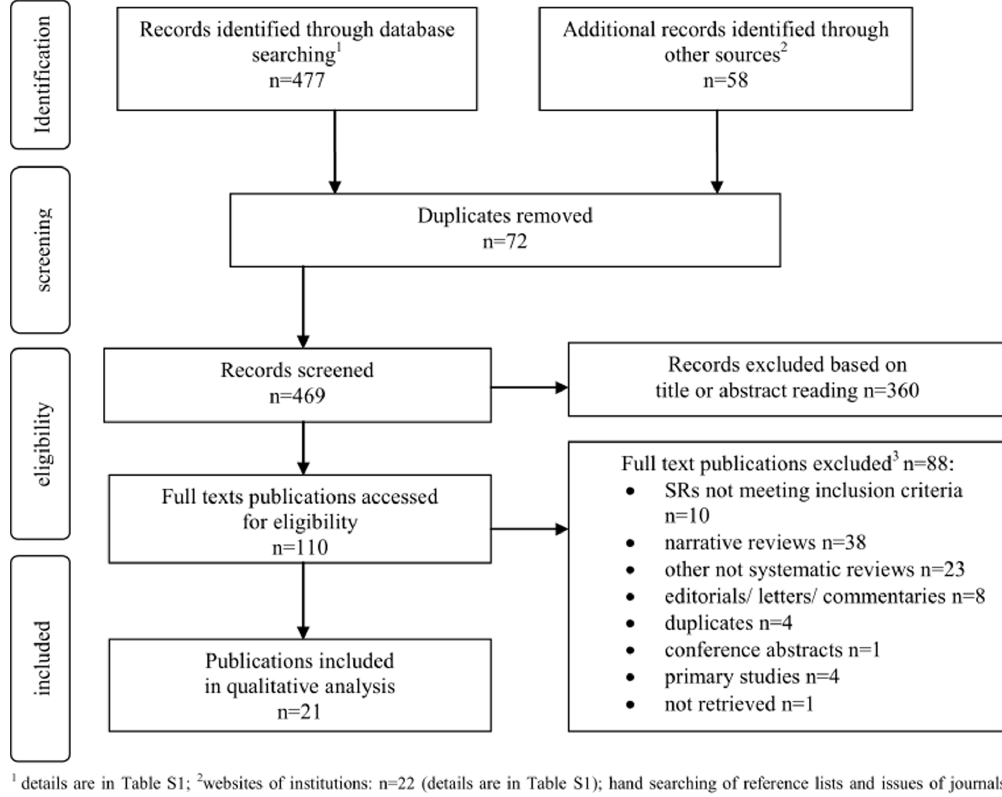
Figure 1. PRISMA flow diagram for the selection of included studies. doi:10.1371/journal.pone.0110254.g001 PLOS ONE |